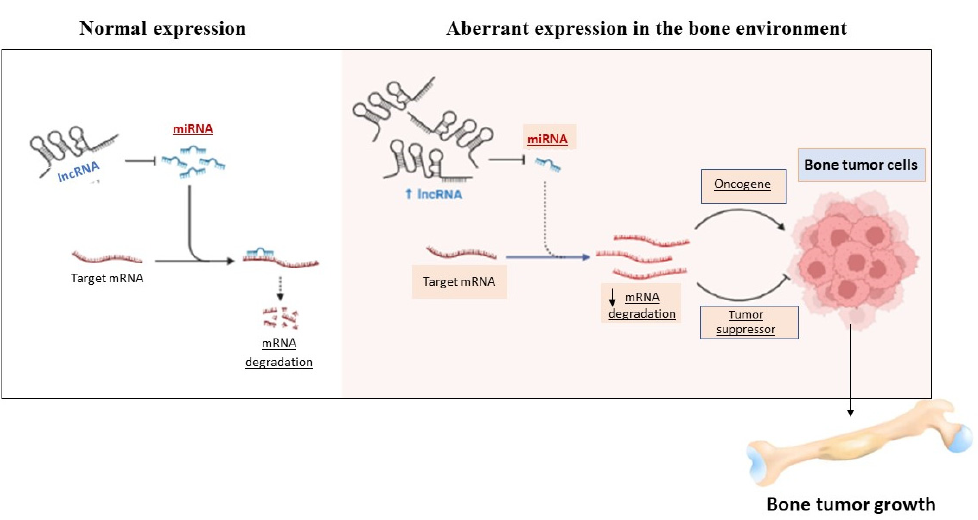
Table 2. List of microRNAs involved in Osteosarcoma, Chondrosarcoma, and Ewing’s